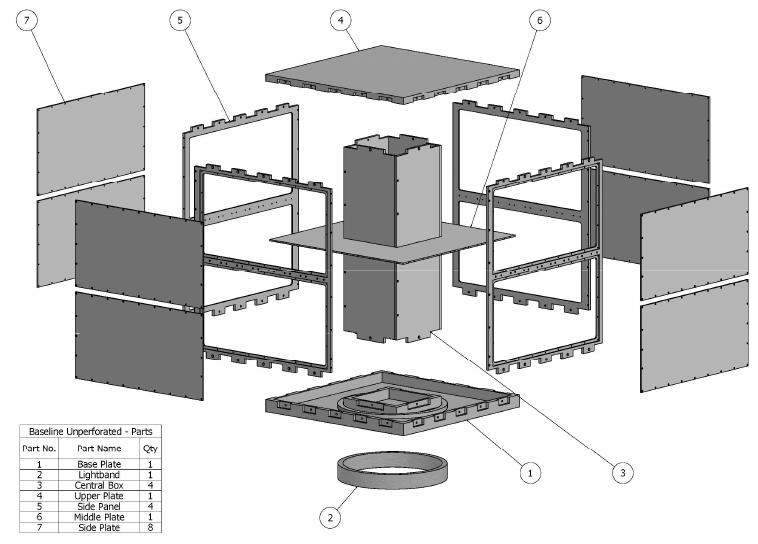
Figure 2. Exploded view of the baseline unperforated structure.